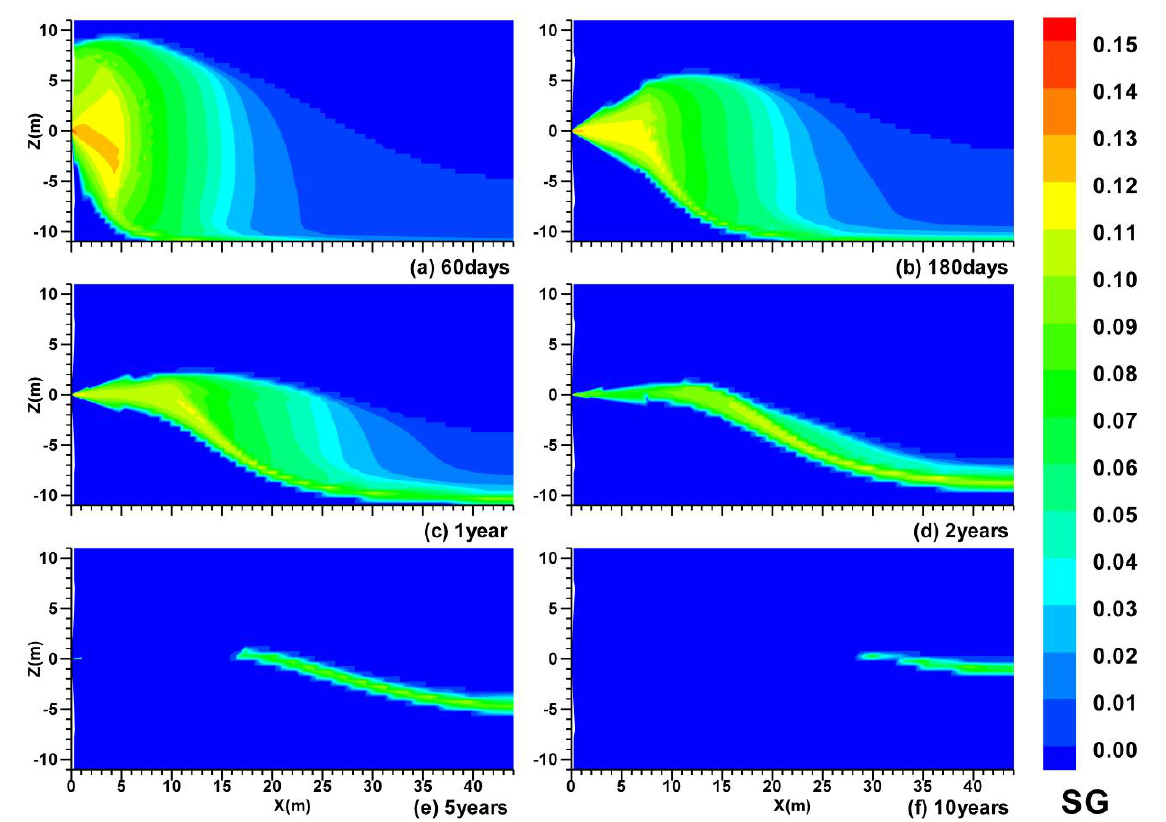
Figure 5. Evolution of spatial distribution of S in Case